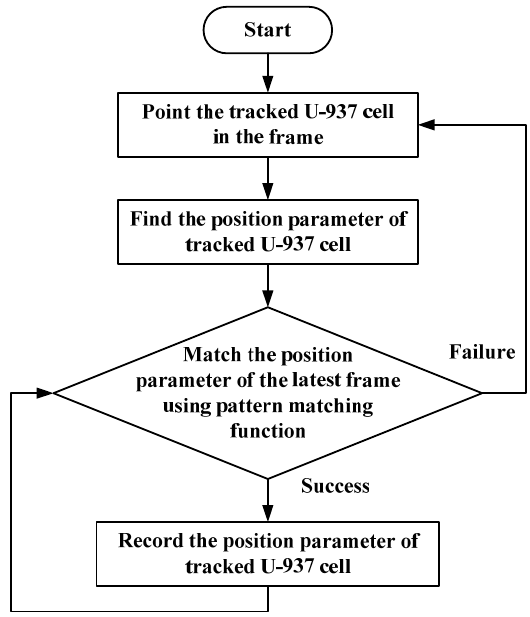
Figure 6. Flow chart for cell